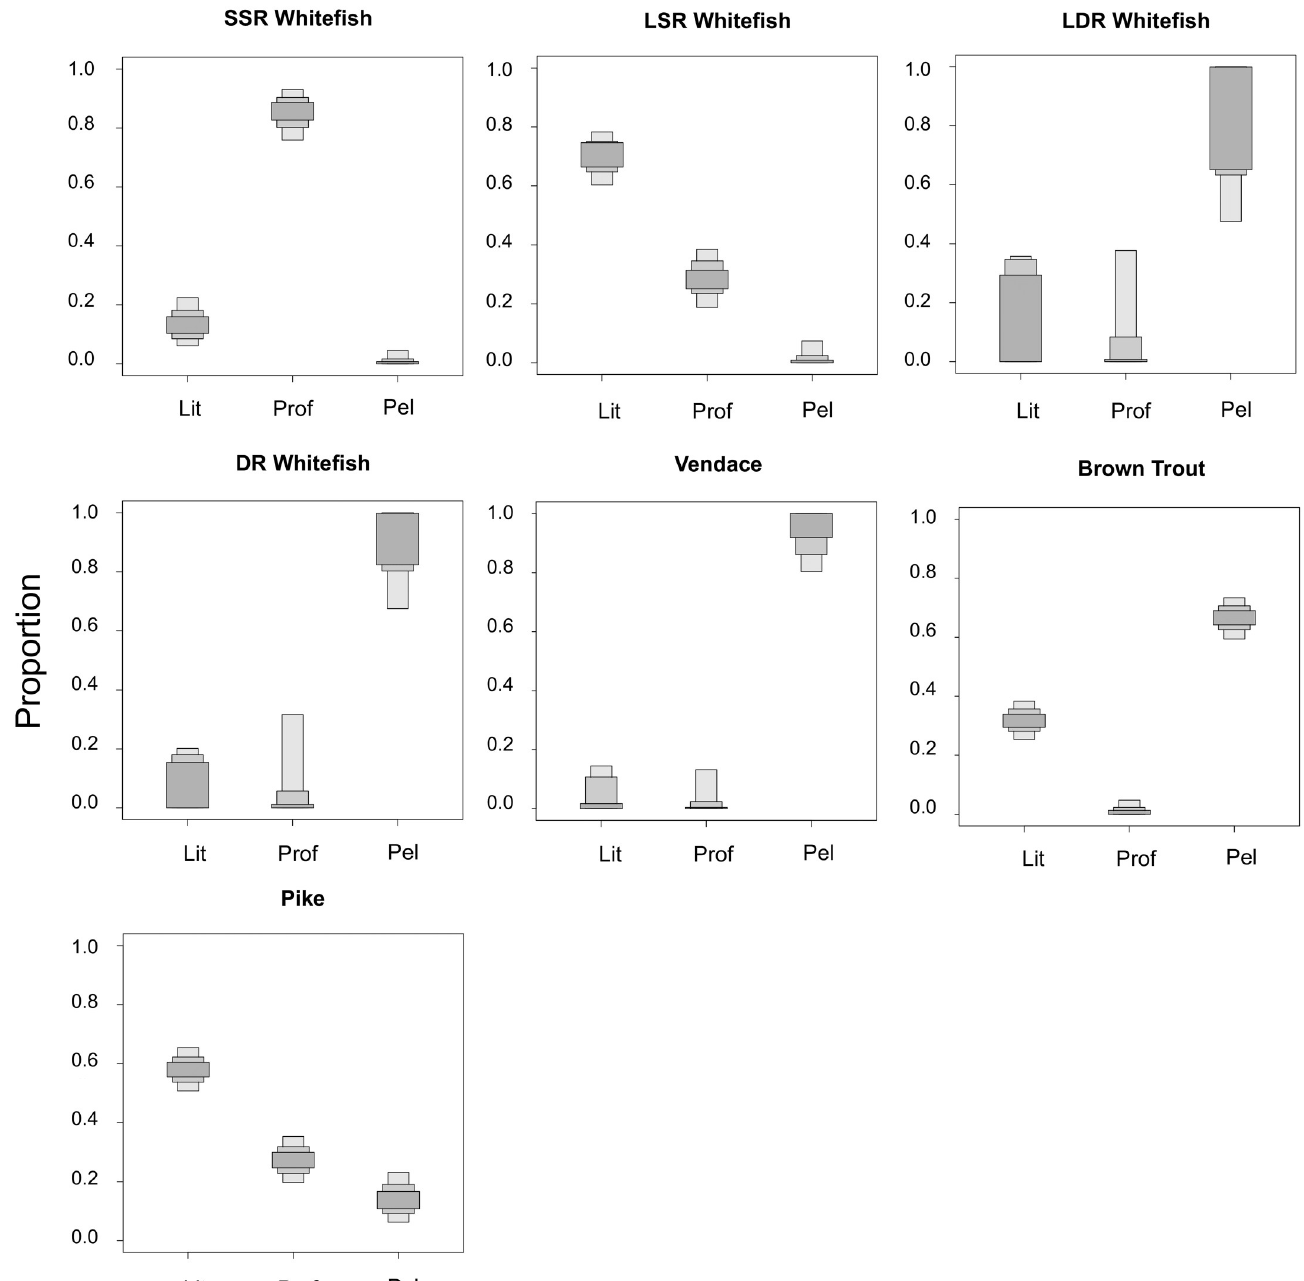
Fig 1. Credibility plots of proportional use of littoral (Lit), profundal (Prof) and pelagic (Pel) resources by seven fish species in lakes of the Paatsjoki watercourse, based on estimates by the Stable Isotope Analysis in R (SIAR) package. Bars represent 95%, 75% and 50% credibility intervals around mean estimates derived from 500,000 iterations, with the first 50,000